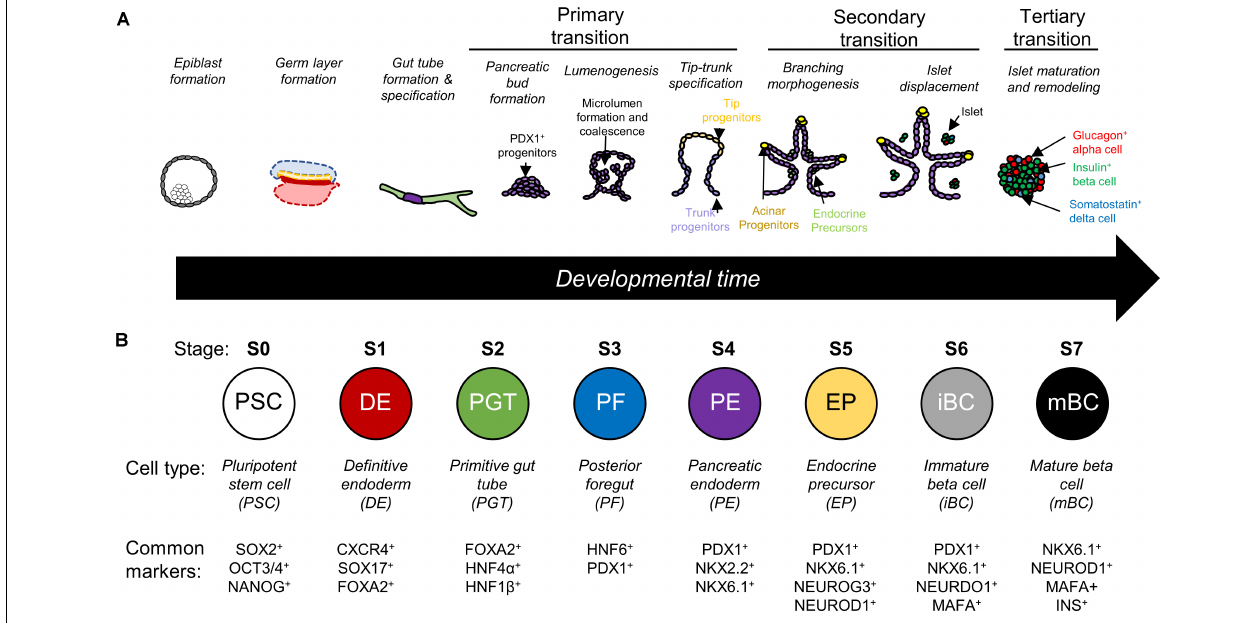
FIGURE 1 | (A) Illustrative schematic of pancreas development which is characterized by three main transitions. Primary transition involves bud formation and specification of different pancreatic cell types. Secondary transition involves branching of the pancreatic bud, further specification of endocrine precursors, and the delamination of islet cells. Tertiary transition involves remodeling of islet architecture and further maturation (Pan and Wright, 2011; Benitez et al., 2012; Jennings et al., 2015; Dassaye et al., 2016). (B) Directed differentiation protocols recreate stages of differentiation in a step-by-step manner and look for expression of key transcription factors. Based on data presented by Rezania et al.